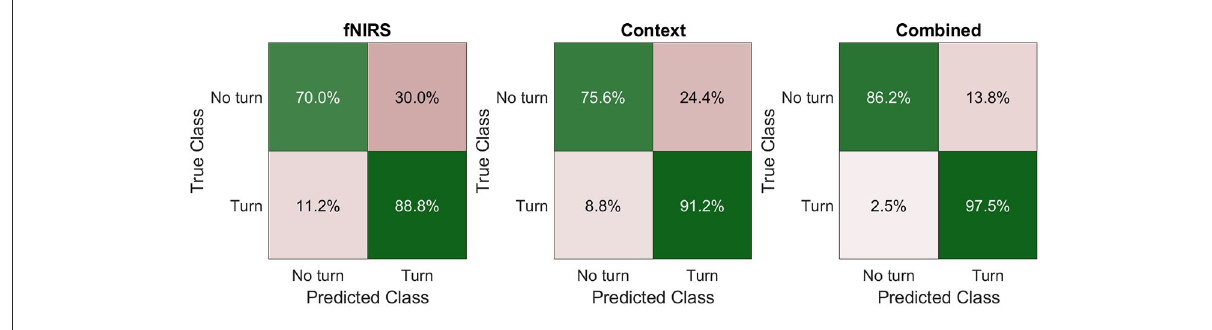
FIGURE5 Average confusion matrices for all three models.